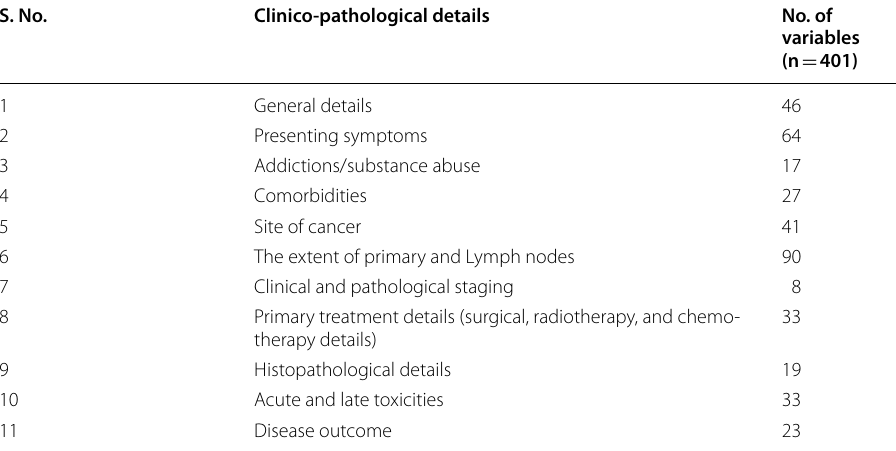
Table 1 Brief description of collected dataset S.